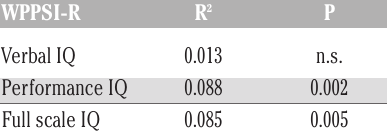
Table 1. Summary of regressions of WPPSI-R IQ scores against the Griffiths general quotient score.